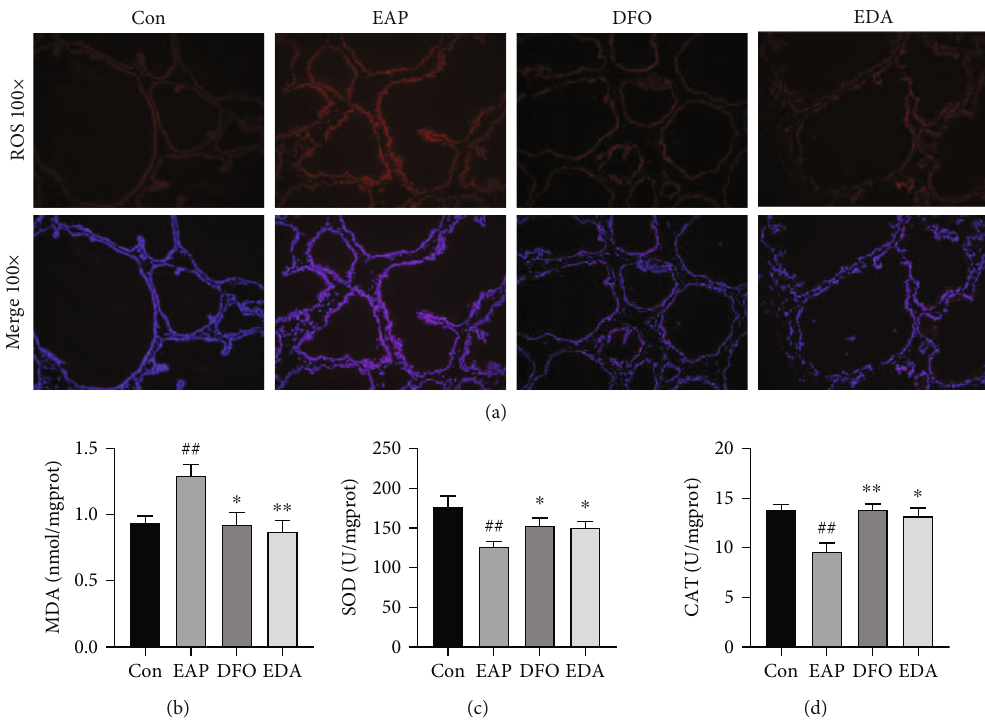
Figure 3: DFO and EDA ameliorated oxidative stress in EAP model. (a) Intercellular ROS generation was evaluated using the fl uorescent probe DCFH-DA. (b – d) The MDA level and SOD and CAT activities of prostate lysates were determined using corresponding methods. Results were normalized to protein concentration and presented as mean ± SEM . ## P < 0 : 01 versus the control group; ∗ P < 0 : 05 versus the EAP group; ∗∗ P < 0 : 01 versus the EAP